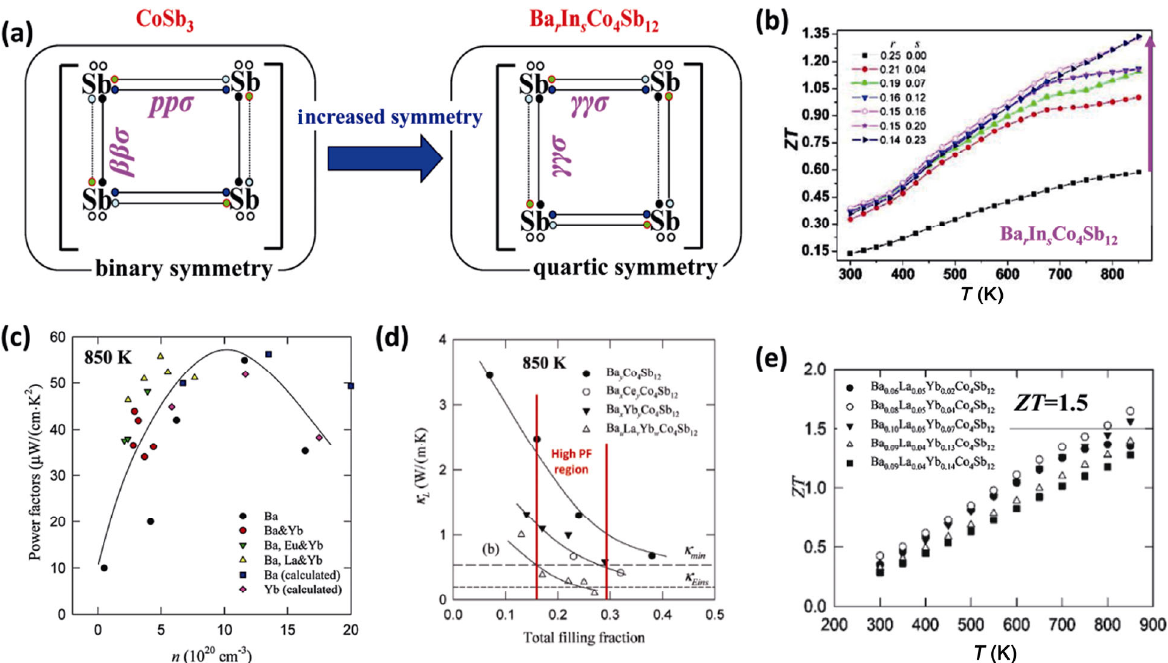
Fig. 3 (a) Improvement of symmetry of the rectangular Sb 4 ring for n-type Ba r In s Co 4 Sb 12 materials induced by the 5p orbital hybridization between the filler In and Sb; (b) temperature dependence of ZT values for Ba r In s Co 4 Sb 12 materials. Reproduced with permission from Ref. [77], © American Chemical Society 2009. (c) Power factors at 850 K as a function of room-temperature carrier density for single-, double-, and multiple-filled skutterudites, and the solid line shows a trend for both the calculated and measured data; (d) high-temperature (850 K) lattice thermal conductivity as a function of total filling fraction; (e) temperature dependence of ZT for Ba u La v Yb w Co 4 Sb 12 multiple-filled skutterudites. Reproduced with permission from Ref. [7], © American Chemical Society 2011.